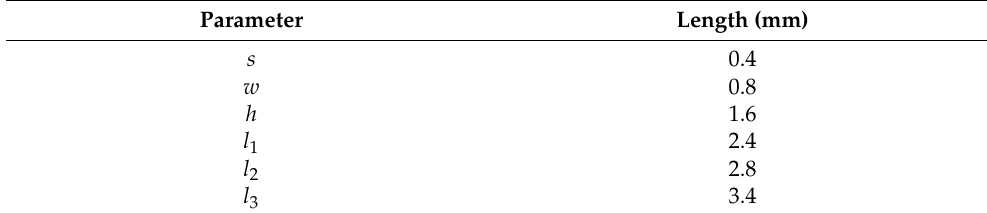
Table 2. Optimized antenna parameters.